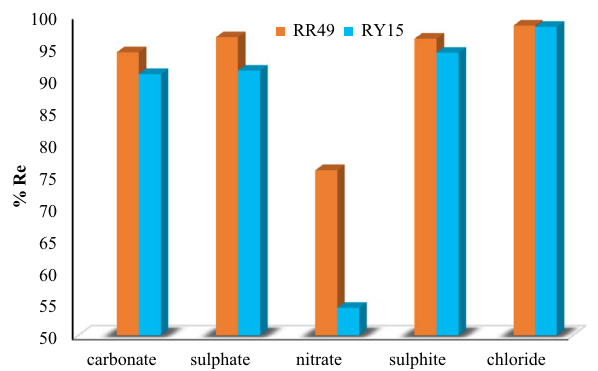
Fig. 7 Effect of supporting electrolyte on %Re of dyes